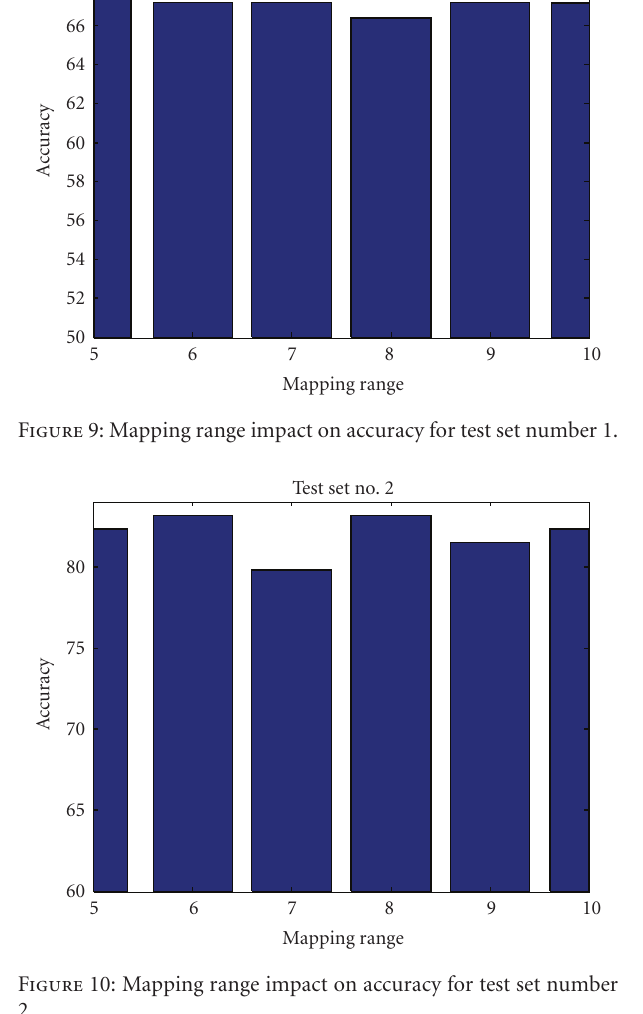
Figure 10: Mapping range impact on accuracy for test set number 2.